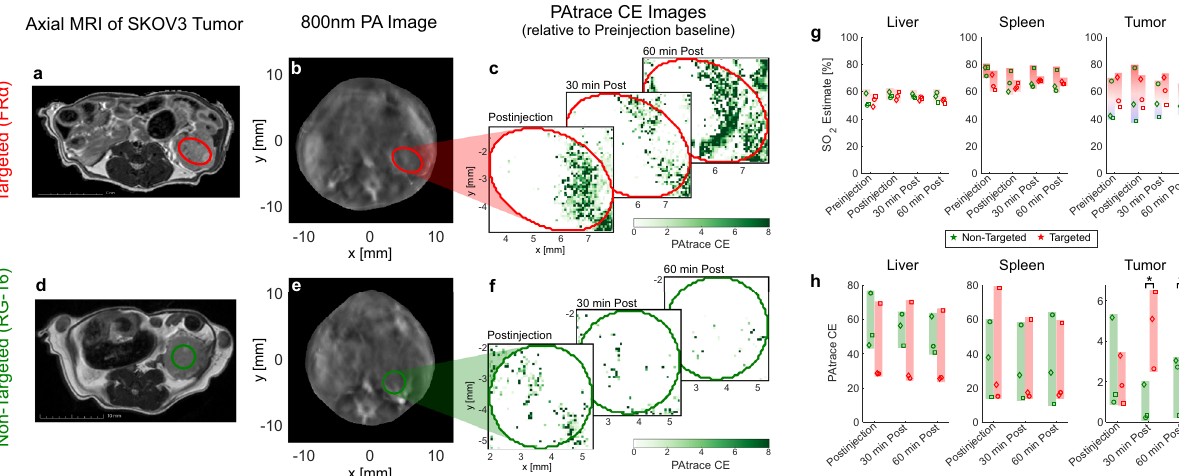
Fig. 6 In vivo PA imaging speci fi city of targeted FR α -PAtrace in orthotopic ovarian cancer model. Results for targeted FR α -PAtrace (red) and non- targeted RG-16-PAtrace (green). Representative a , d axial MRI and b , e 800nm PA image of SKOV3 tumors with ROIs indicated by red/green ellipses. MRI volumes were used to establish the position and size of tumors in PA images for ROI placement. Representative PAtrace contrast enhancement (CE) images thru postinjection time-points of c targeted FR α -PAtrace and f non-targeted RG-16-PAtrace. g PA-based SO 2 estimates for liver (left), spleen (middle), tumor (right) ROIs show that SO 2 does not change signi fi cantly through time, indicating no substantial physiological changes occurred during imaging. h PAtrace CE in the liver (left) and spleen (middle) ROIs suggest no signi fi cant difference between FR α -PAtrace and RG-16-PAtrace liver or spleen accumulation. PAtrace CE in tumor ROIs (right) presents positive enhancement for both targeted and non-targeted PAtrace immediately postinjection, but with targeted enhancement signi fi cantly greater 30 min ( p = 0.017) and 60 min ( p = 0.044) postinjection. Error bars indicate mean ± SD across three independent